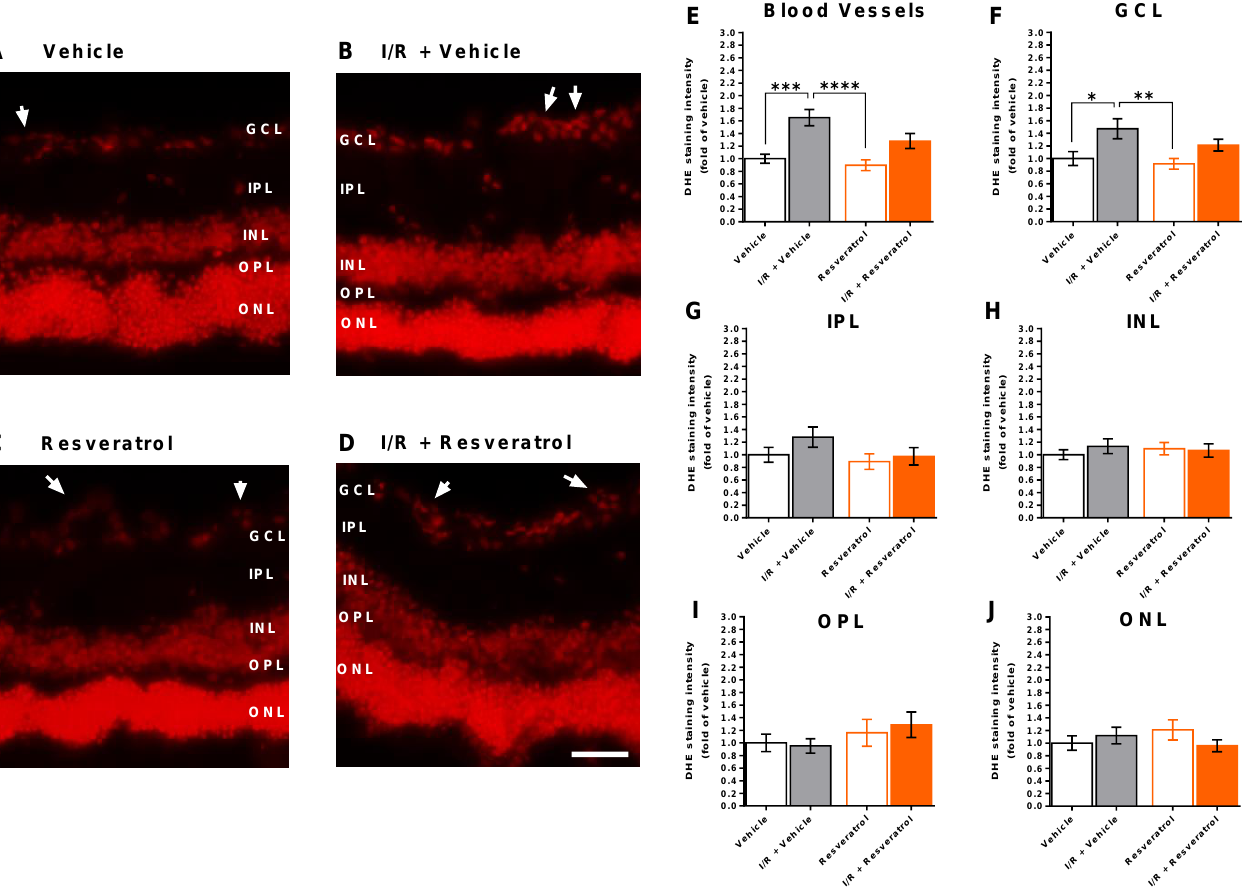
Figure 3. Dihydroethidium (DHE) staining in retinal cryosections. ( A – D ) Representative pictures of retinal cross-sections from each group. The white arrows point to the blood vessels. Scale bar = 50 µm. ( E – J ) DHE staining intensity was markedly increased in retinal blood vessels ( E ) and in the GCL ( F ) from I/R- and vehicle-treated eyes. In other retinal layers, no significant differences in DHE stain- ing intensity were observed among groups ( G – J ). Values are expressed as means ± SE (**** p < 0.001; *** p < 0.001; ** p < 0.01; * p < 0.05; n = 8 per group). GCL, ganglion cell layer; IPL, inner plexiform layer; INL, inner nuclear layer; OPL, outer plexiform layer; ONL, outer nuclear